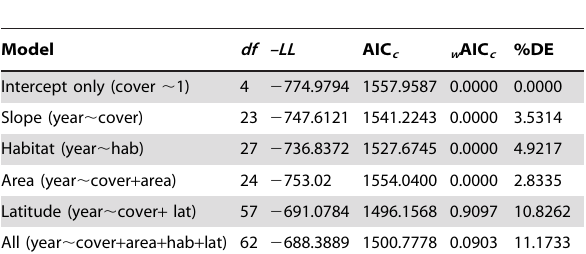
Table 3. Results of the relationship between coral cover at Ningaloo Reef and explanatory variables using general linear mixed-effects model comparison based on Akaike’s information criterion (AIC c ) corrected for small sample